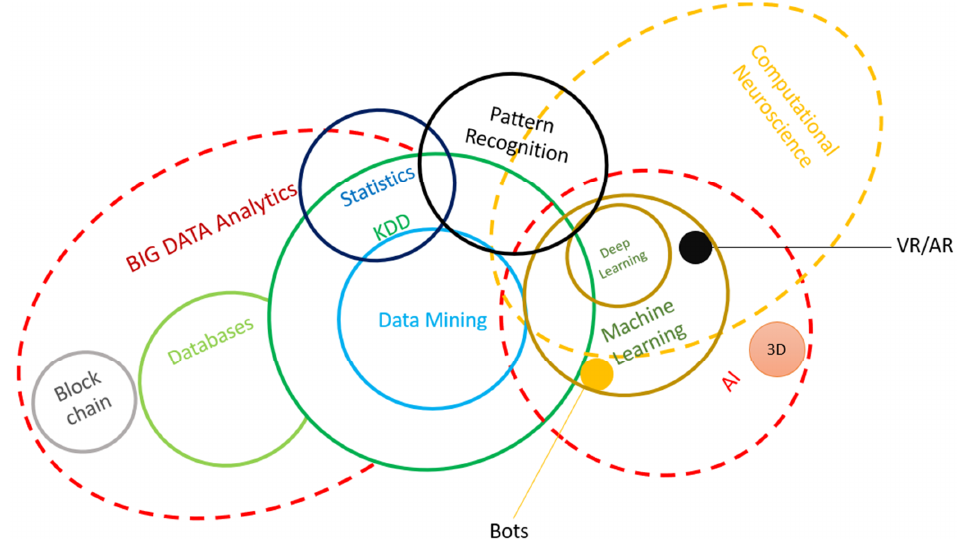
Figure 2. Overlapping fields of research contributing to big data.